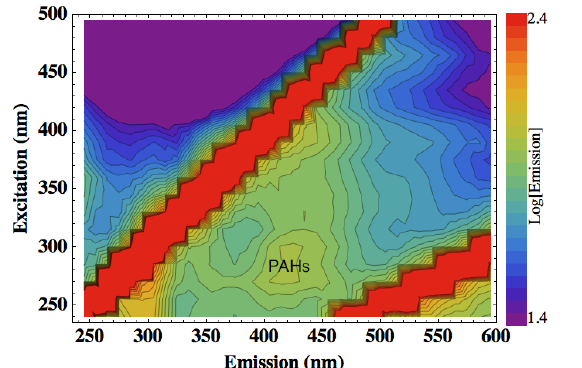
Figure 3. The EEM generated for the weathered crude oil sample. The fluorescence intensity is shown on the right hand side of the EEM on a Log 10